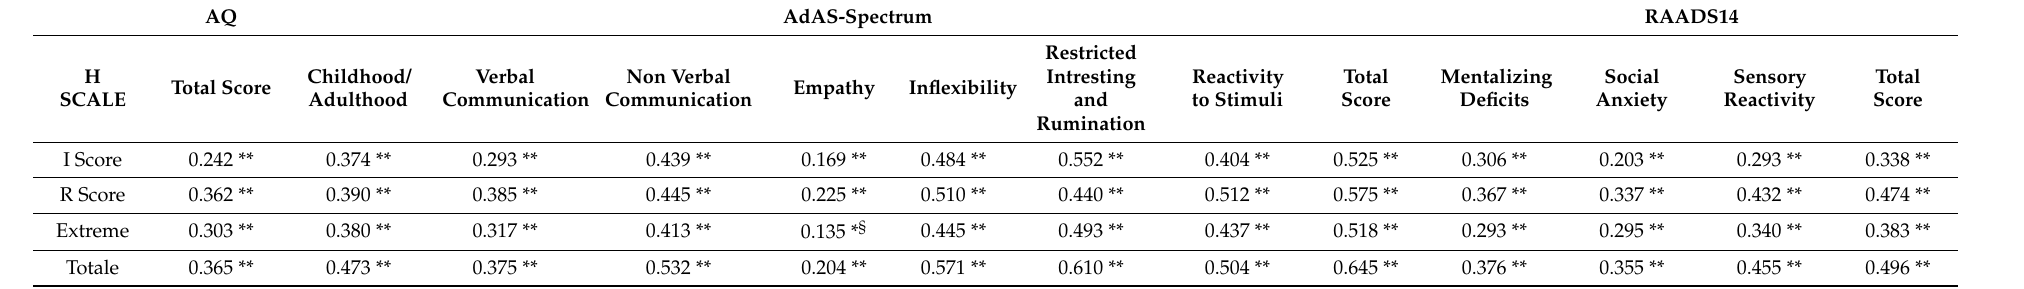
Table 4. Correlation analysis (Pearson correlation) between arousal (H-Scale) and autistic traits (AQ, AdAS-Spectrum and RAADS14) in females. AQ AdAS-Spectrum RAADS14 Childhood/ Verbal Non Verbal H Empathy Inflexibility Total Score Adulthood Communication Communication SCALE